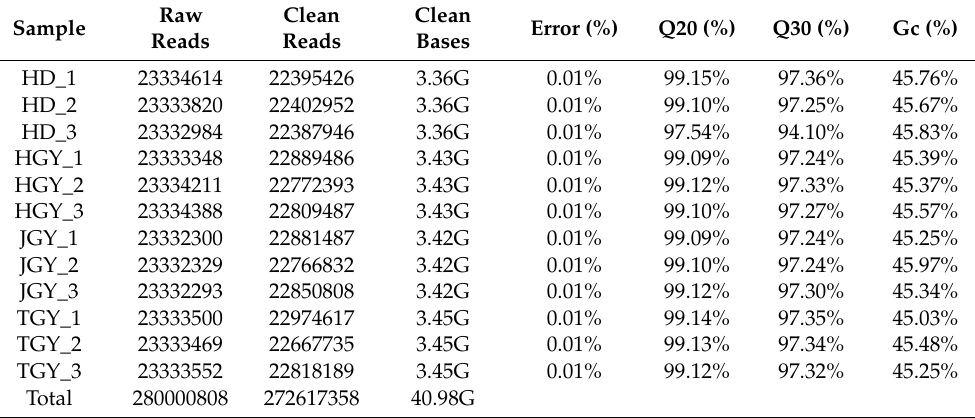
Table 3. Sequencing data statistics derived from HD, HGY, JGY and